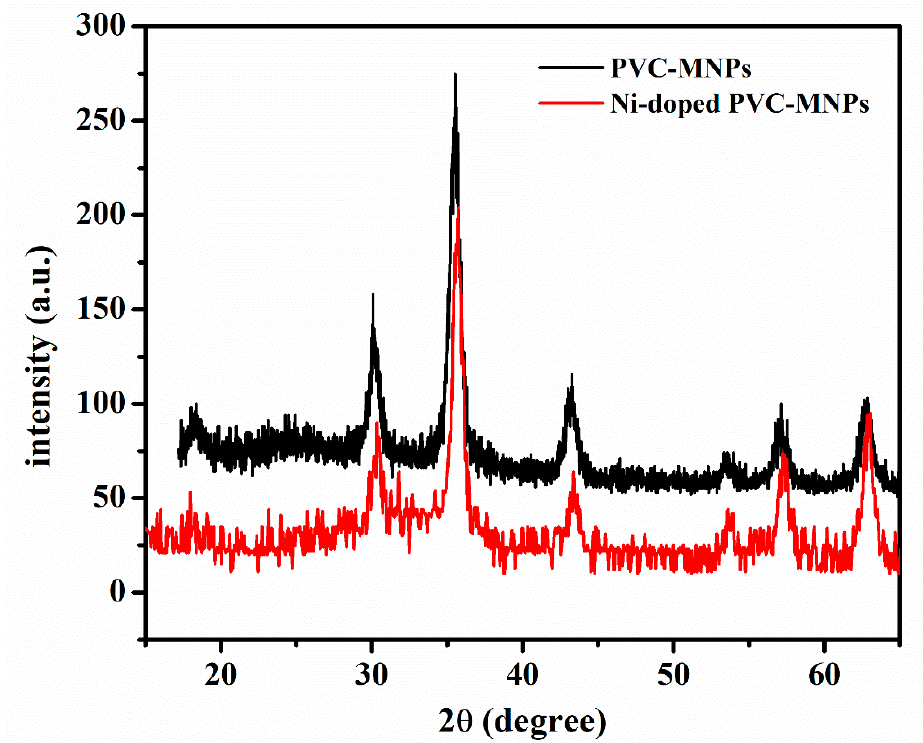
Figure 2. XRD patterns of the synthesized polyvinyl chloride (PVC) surface-functionalized magnetic nanoparticles (PVC-MNPs) and Ni-doped PVC–MNPs. J. Compos. Sci. 2020 , 4 , x FOR PEER REVIEW